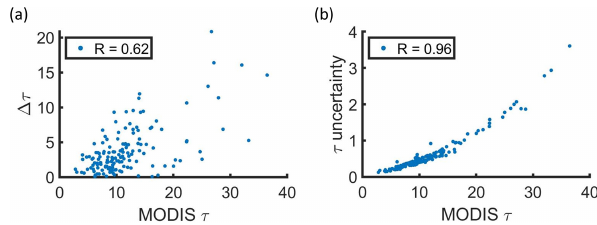
Figure 9. MODIS τ versus (a) the magnitude of the difference be- tween MODIS τ and in situ τ ( (cid:49) ) and (b) the MODIS τ retrieval uncertainty for profiles with a MODIS retrieval co-located with in situ data for (cid:49)T less than 3600s. Each point represents the average value over a 5 × 5 pixel domain.